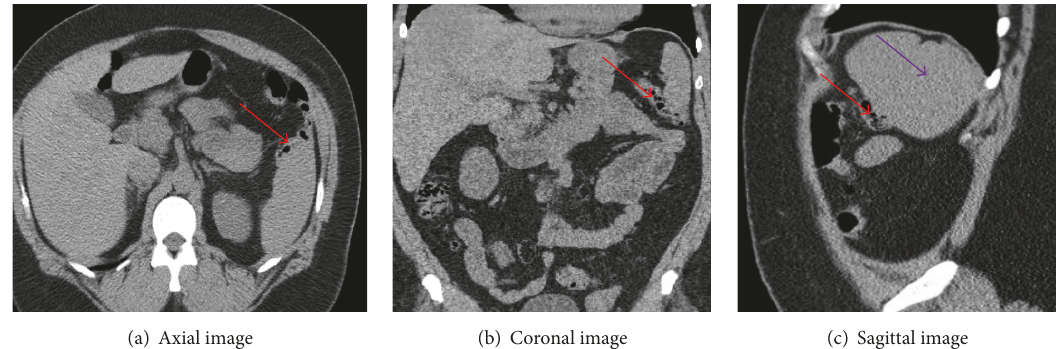
Figure 2: CT, 06/06/12: diverticula abutting the splenic capsule of the lower pole (red arrows) with splenomegaly (purple